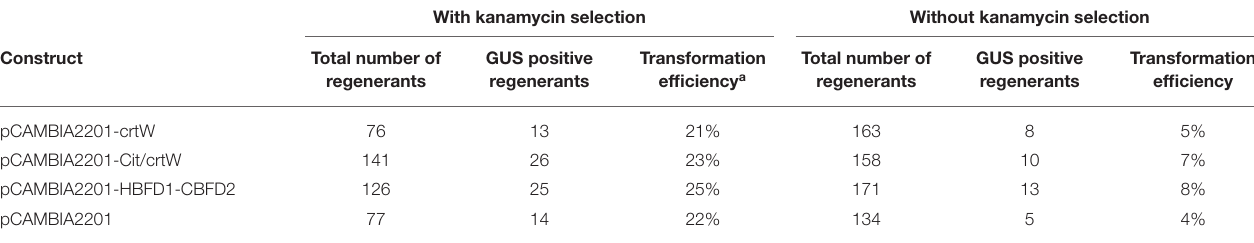
TABLE 1 | Transformation efficiency of N. benthamiana on media with antibiotic selection compared to media without antibiotic selection. With kanamycin selection